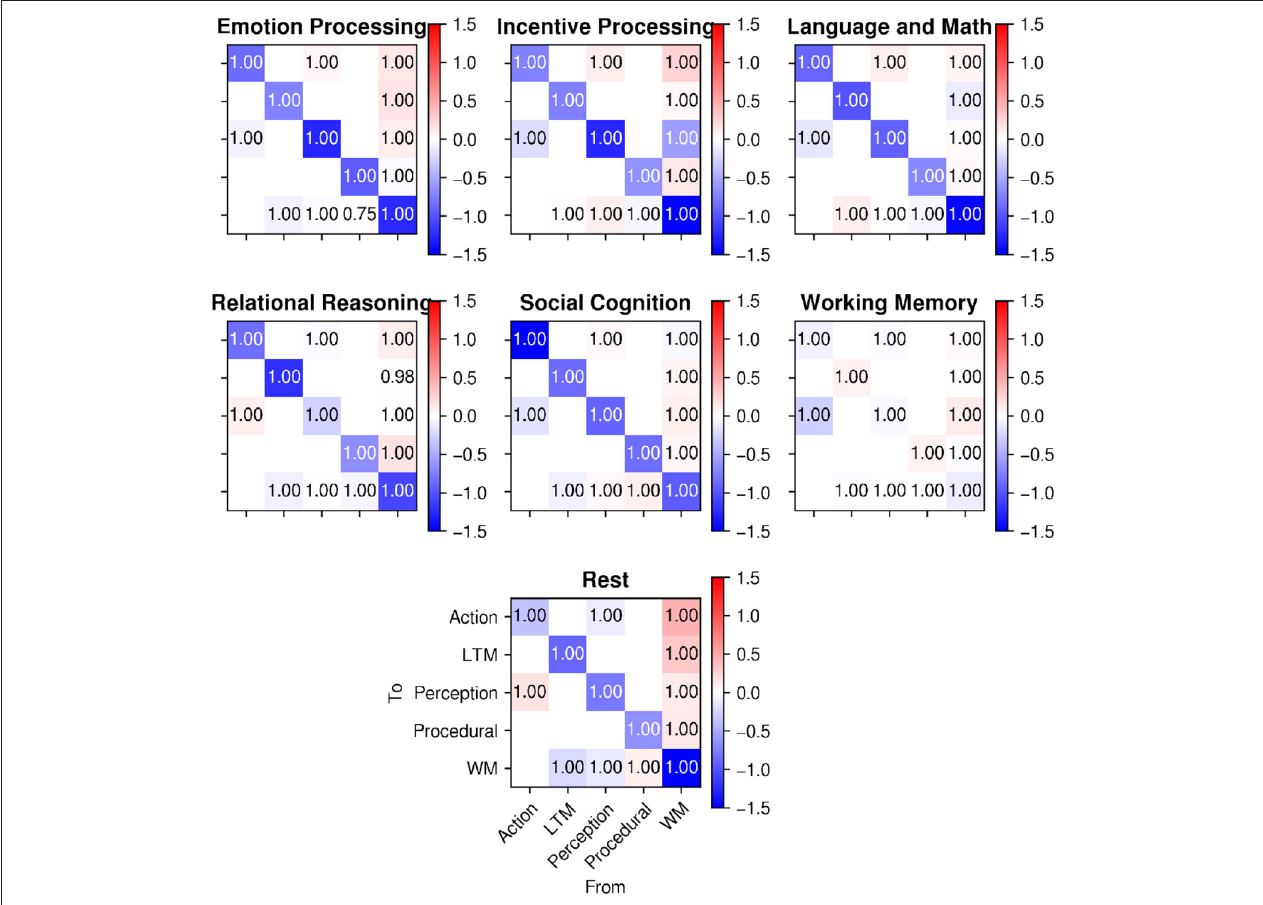
FIGURE 10 | A comparison of intrinsic connectivity between regions (matrix A in Equation 1) during task-based activity ( top ; from Stocco et al., 2021) and during rest (bottom) . Cell colors represent connection weights; numbers in the cells represent posterior probabilities that the weights are different from